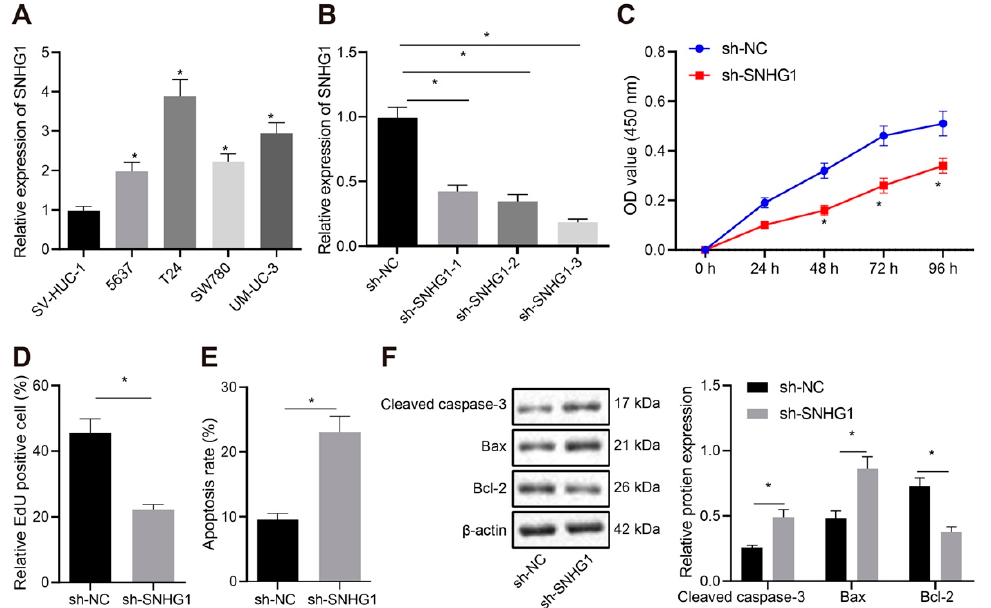
Figure 2. Silencing SNHG1 inhibits bladder cancer cell proliferation and promotes cell apoptosis. ( A ) qRT-PCR detecting the expression of SNHG1 in one normal urothelial cell line SV-HUC-1 and four bladder cancer cell lines (5637, T24, SW780, and UM-UC-3), and selection of T24 cells with the highest expression and 5367 cells with the lowest expression for subsequent experiments. T24 cells were transfected with si-NC or si-SNHG1. ( B ) qRT-PCR determination of the silencing efficiency of three sh-SNHG1 in T24 cells, and screening out of the highest silencing efficiency sh-SNHG1-3. ( C ) CCK-8 assay of the change of T24 cell viability. ( D ) The changes of T24 cell proliferation detected by EdU assay. ( E ) Flow cytometry analysis of the changes of T24 cell apoptosis. ( F ) Western blot anal- ysis of the expression of Cleaved caspase-3, Bax, and Bcl-2 in T24 cells. * p < 0.05. The experiment was repeated three times. Data were presented as mean ± standard deviation and compared by one- way analysis of variance (ANOVA), followed by Tukey’s post hoc test.